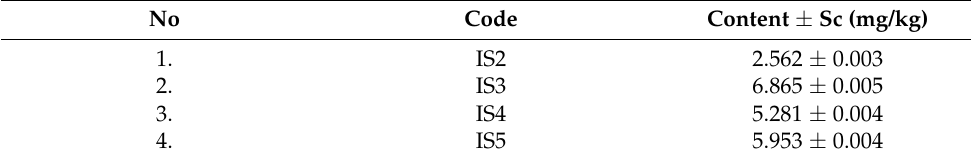
Table 7. Arsenic level in sediment